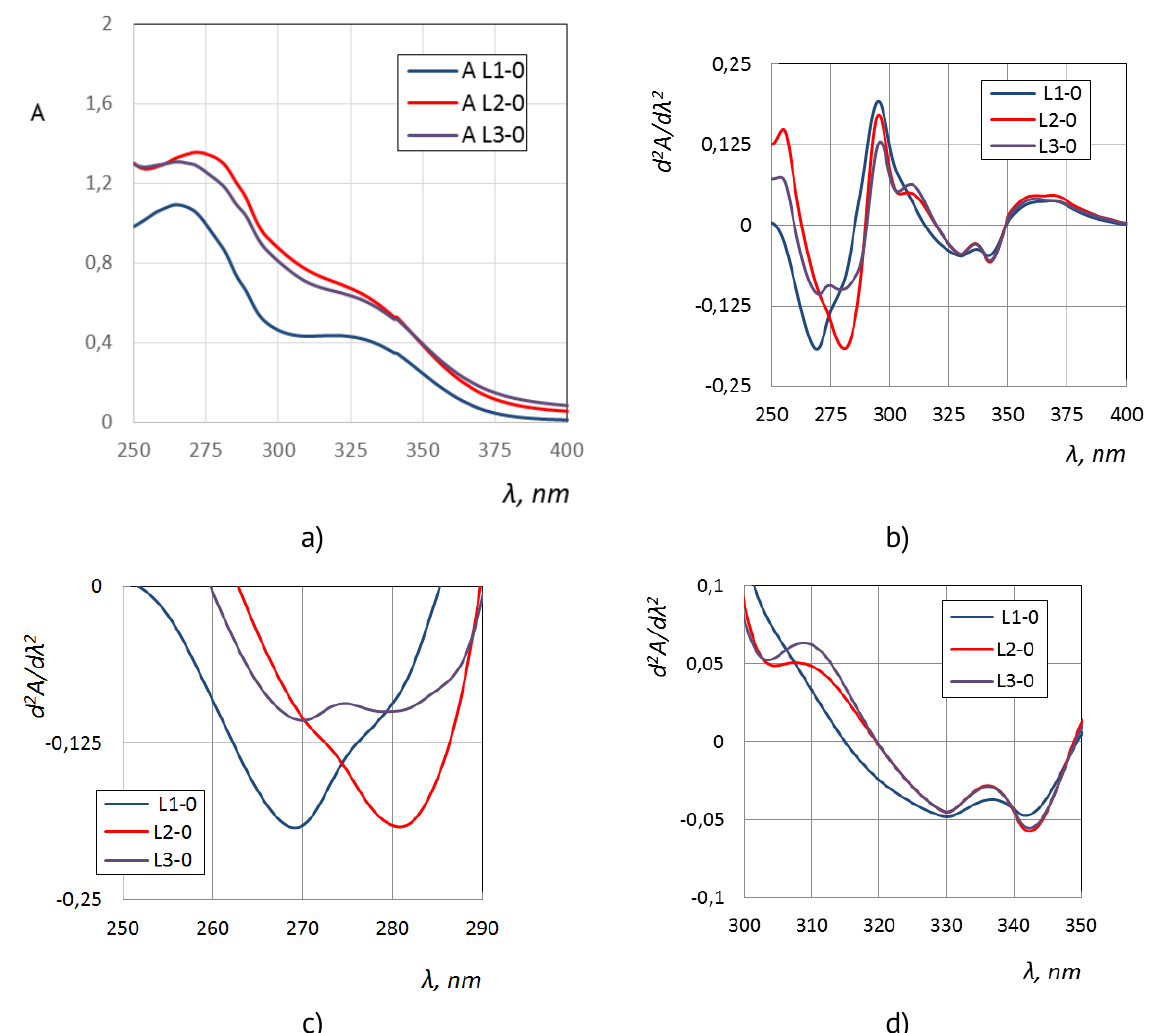
Figure 1. The absorption spectra of experimental raw wines Legenda with different level of oxidation (L1-0, L2-0 and L3-0 ‒ a), and its second order derivative spectra (b, c, d). The wines are undiluted, the cuvettes path length – 0,1